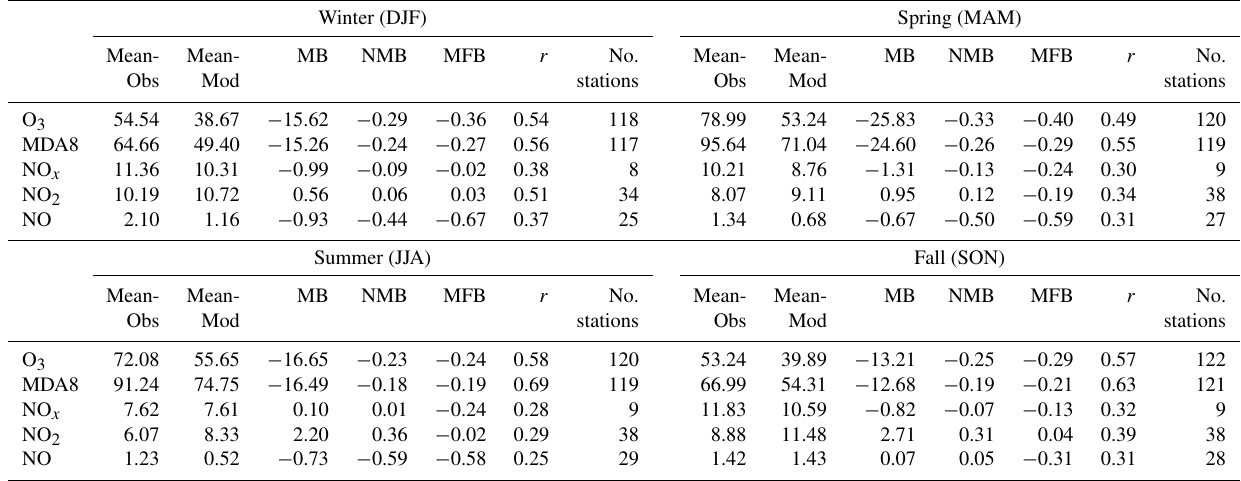
Table 9. Statistics for RADM2 simulation against hourly observations from the EMEP network. Means and MB are expressed in µgm − 3 ; NMB, MFB, and r are unitless. r is the hourly temporal correlation coefficient for all quantities except MDA8, for which it represents the daily temporal correlation